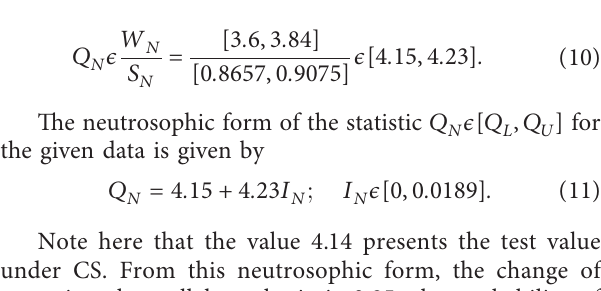
Figure 8: Comparison of the proposed test and the existing test for neutrosophic t